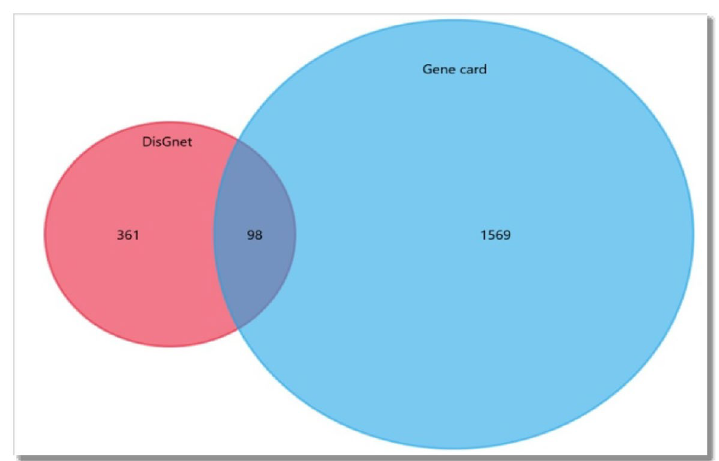
Figure 1. Venn diagram showing the target genes for HCC based on different